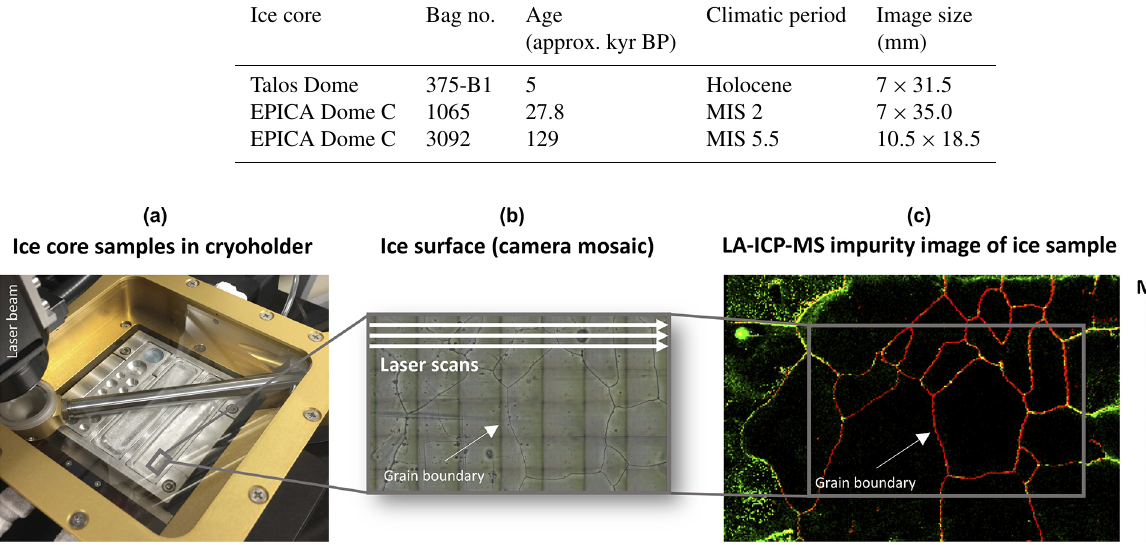
Figure 1. Generating 2-D impurity images of ice cores by LA-ICP-MS. Strips of ice (approx. 9 × 2, 1.5cm thickness) are kept frozen in a custom-designed cryogenic holder (a) . A mosaic of optical images allows localizing ice surface features such as grain boundaries (b) . Data from an array of non-overlapping laser scan lines are stacked without interpolation to generate an elemental map of impurities distribution (c)